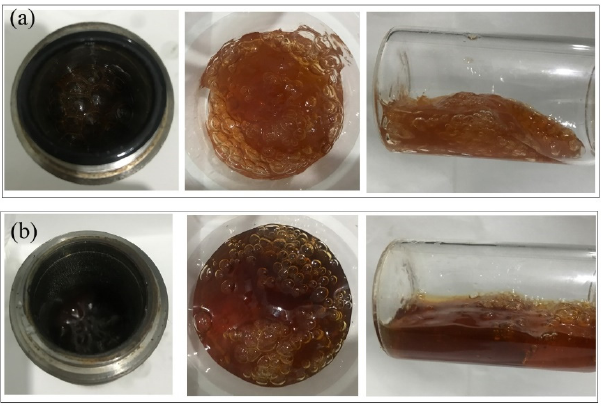
Figure 5. Gel morphology after aging for 180 days at 2 MPa. ( a ) Control group—N 2 ; ( b ) flue gas.